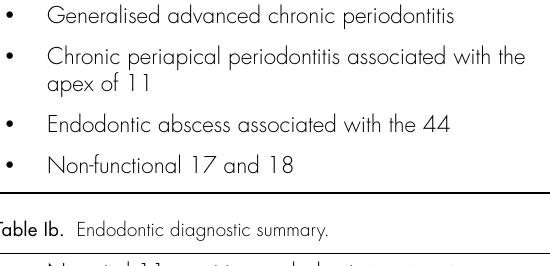
Table Ia. Periodontal diagnostic summary.